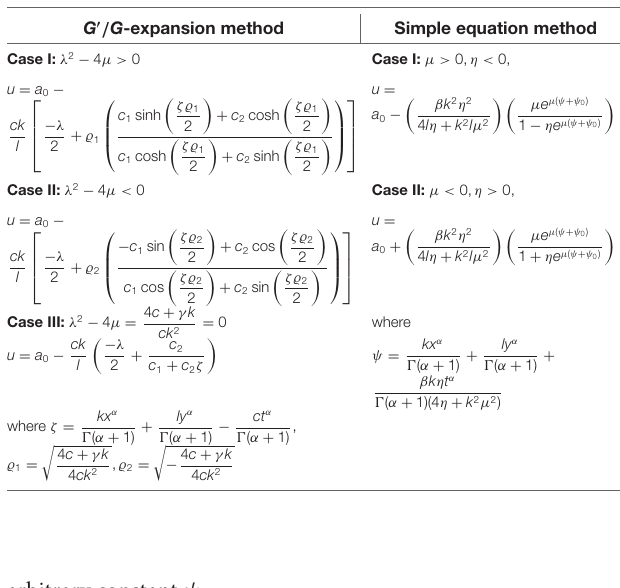
TABLE 2 | Solutions comparison of the non-linear space-time fractional Ablowitz-Kaup-Newell-Segur (AKNS) equation between G ′ / G -expansion method and simple equation (SE)